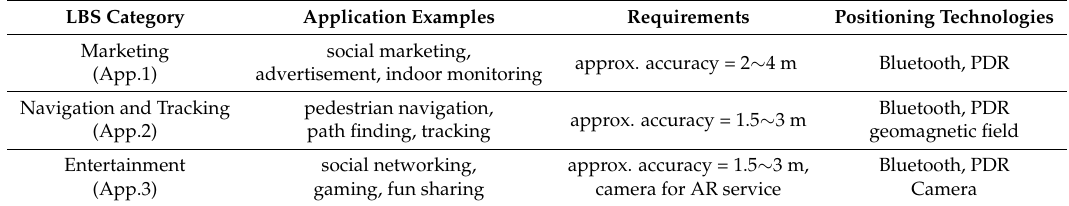
Table 1. LBS application, and required features, and used